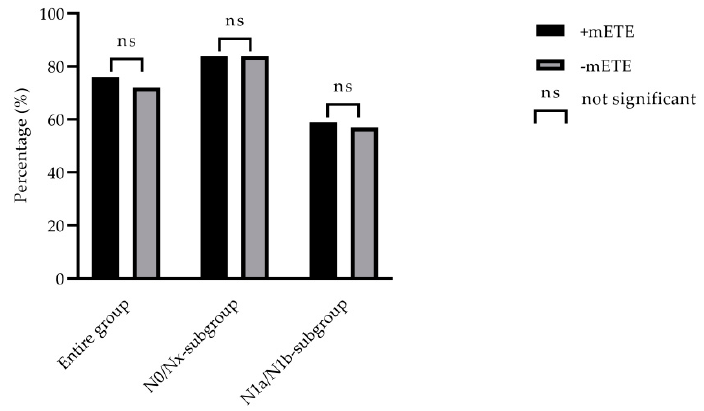
Figure 1. Responder rates (in %) of the entire group and the N-subgroup. No significant differences were found regarding responder rates in the entire group and among N0/Nx- and N1a/N1b- subgroups.